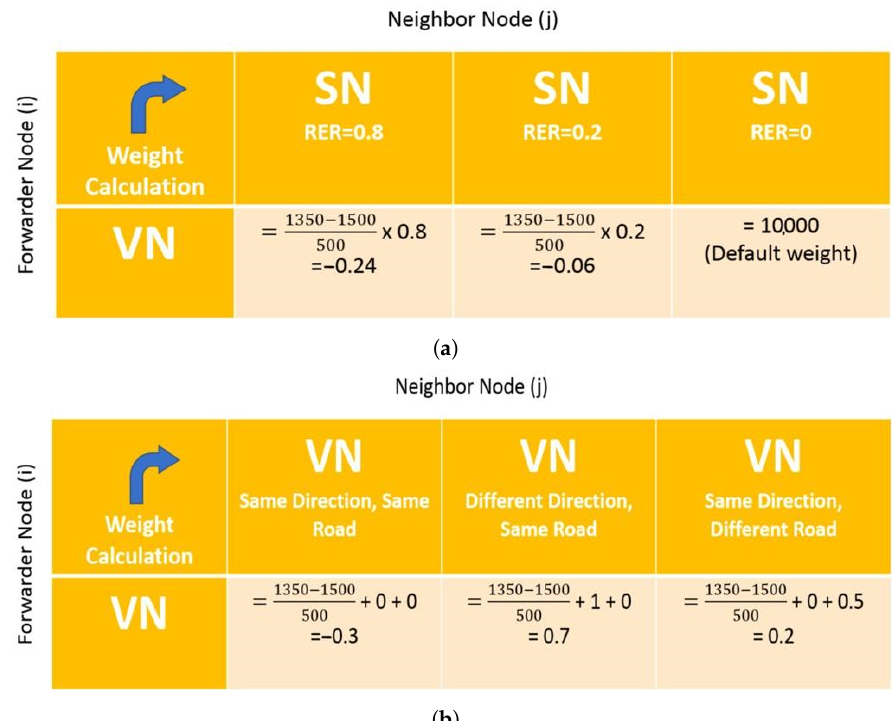
Figure 5. Examplesfor a forwarder vehicle and the weight calculation for its neighbors. ( a ) Example 3. ( b ) Example